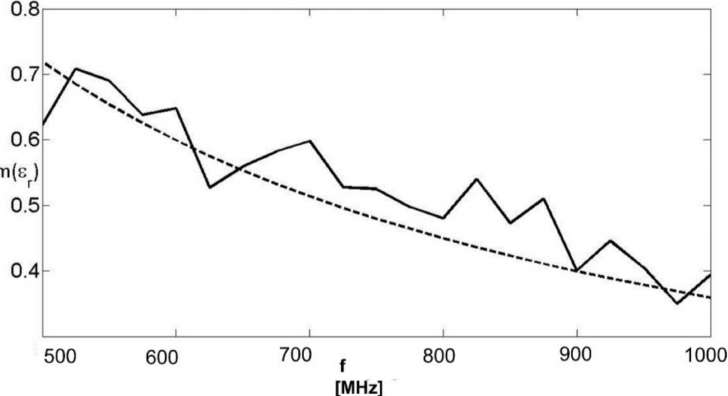
Figure 6. Imaginary part of the equivalent complex permittivity. Solid line: retrieved value; dashed line: actual value. Noisy data with SNR = 10